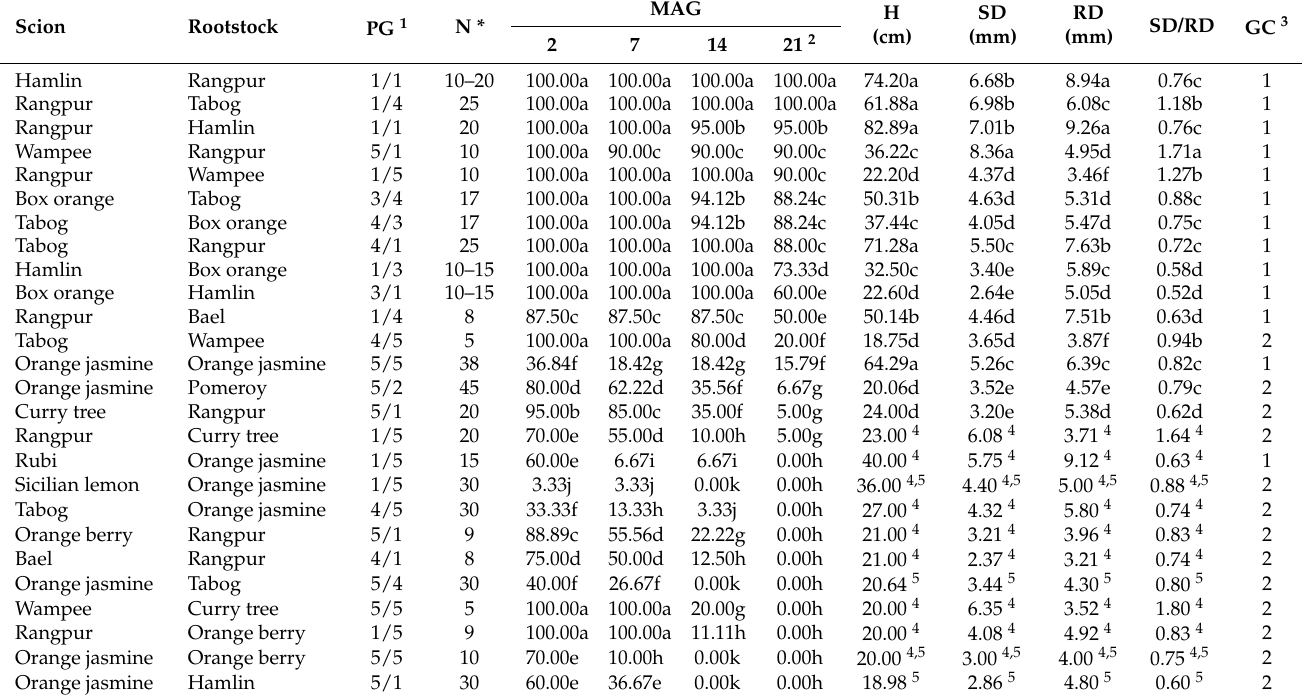
Table 2. Graft-take percentage of the first group of scion/rootstock genotypes combinations within different Aurantioideae phylogenetic groups (PGs) at 2, 7, 14, and 21 months after grafting (MAG), mean values of plant height (H), scion stem diameter (SD), rootstock stem diameter (RD), scion and rootstock stem diameter relation (SD/RD) at 14 MAG or before plant’s death, and graft compatibility group